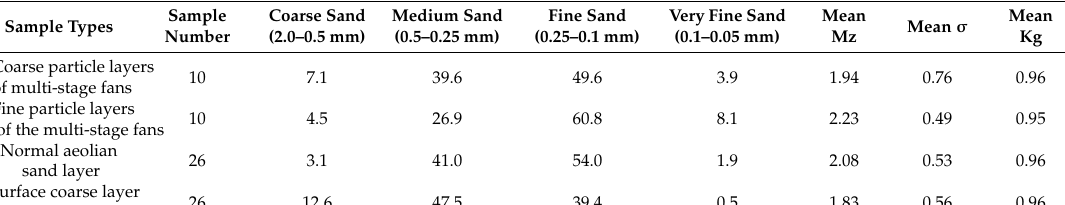
Table 3. Mean grain size content and parment of multi-stage fans in the megadune of eastern Nuoertu Lake (%).